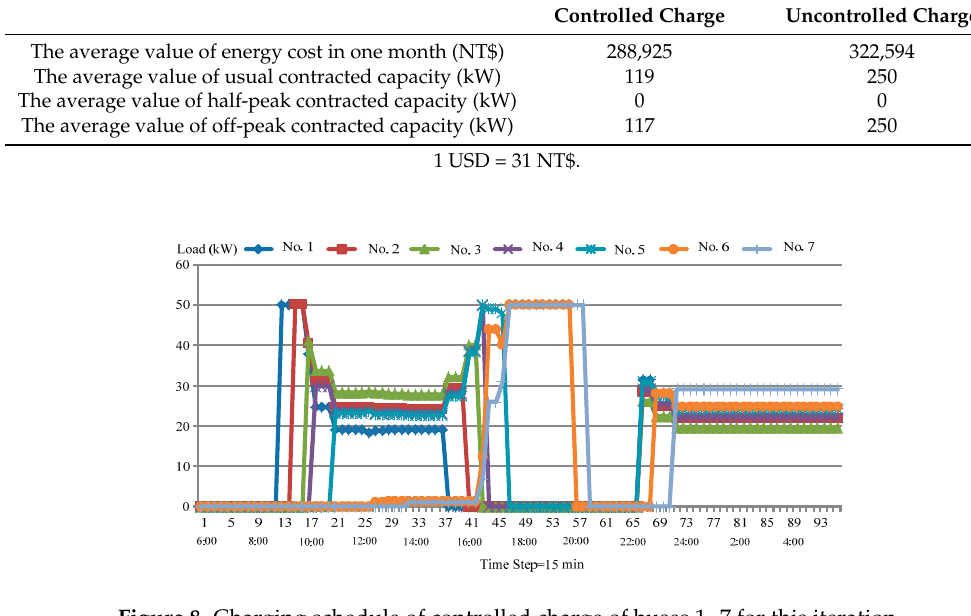
Figure 8. Charging schedule of controlled charge of buses 1~7 for this iteration.